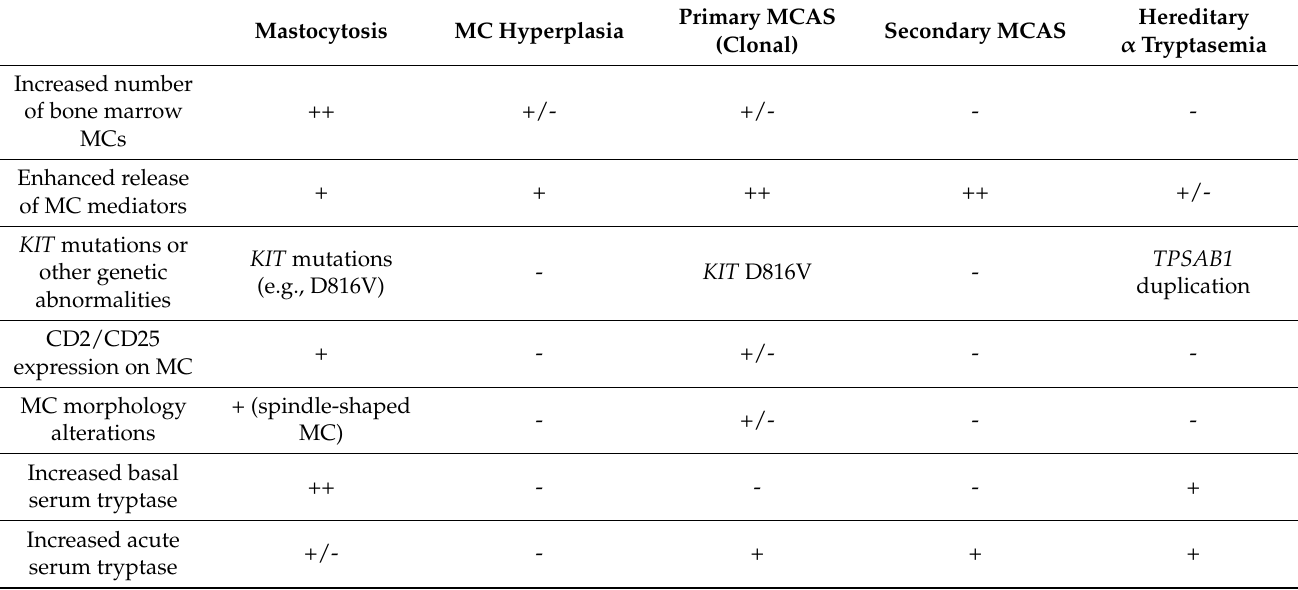
Table 2. Main features of mast cell (MC)-related